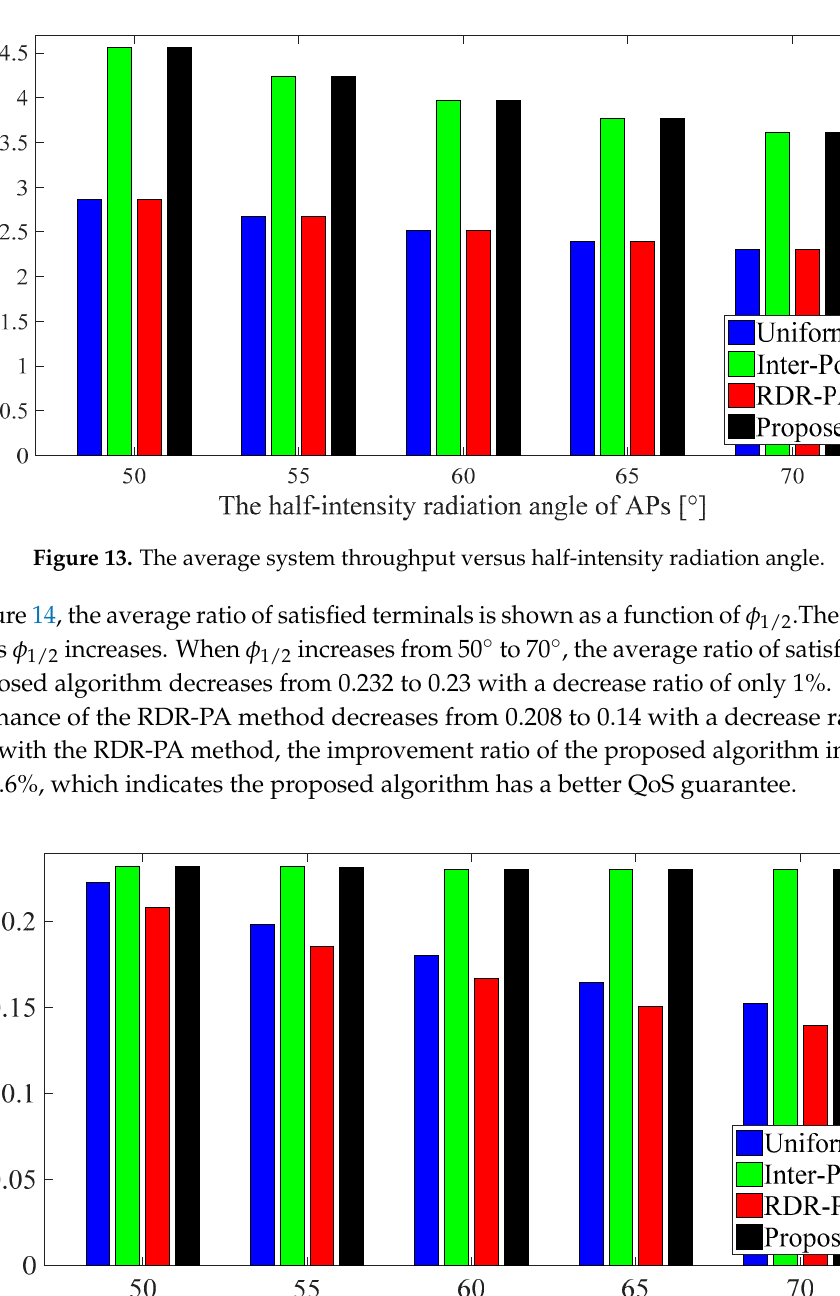
Figure 12. The average ratio of satisfied terminals versus the field of view.